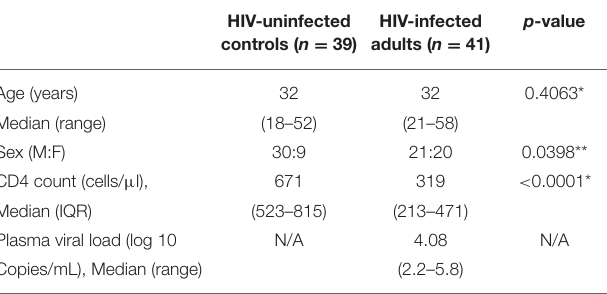
TABLE 1 | Demographics of study participants.